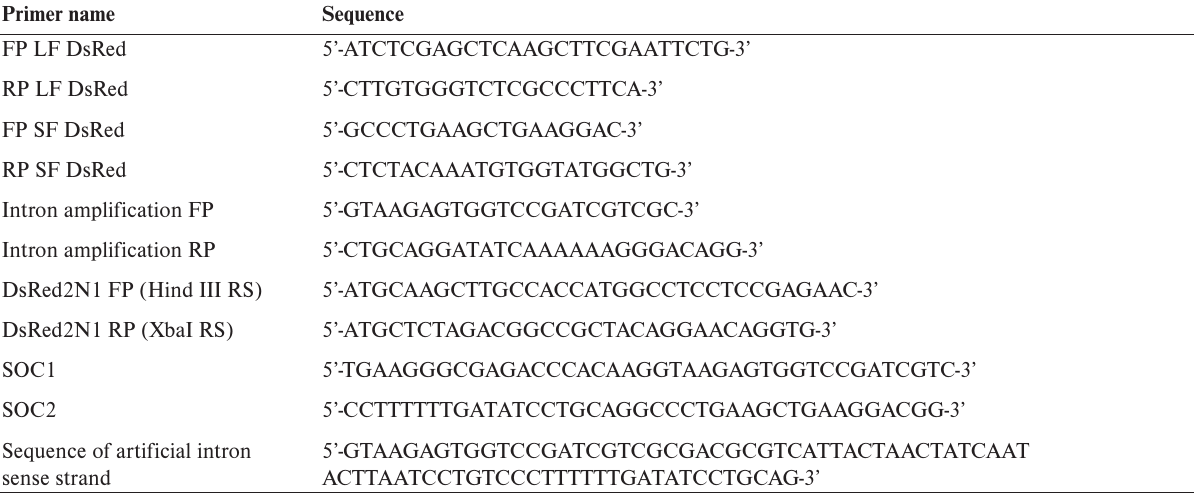
Table 1. Sequences of synthetic oligonucleotides used in the experiment.